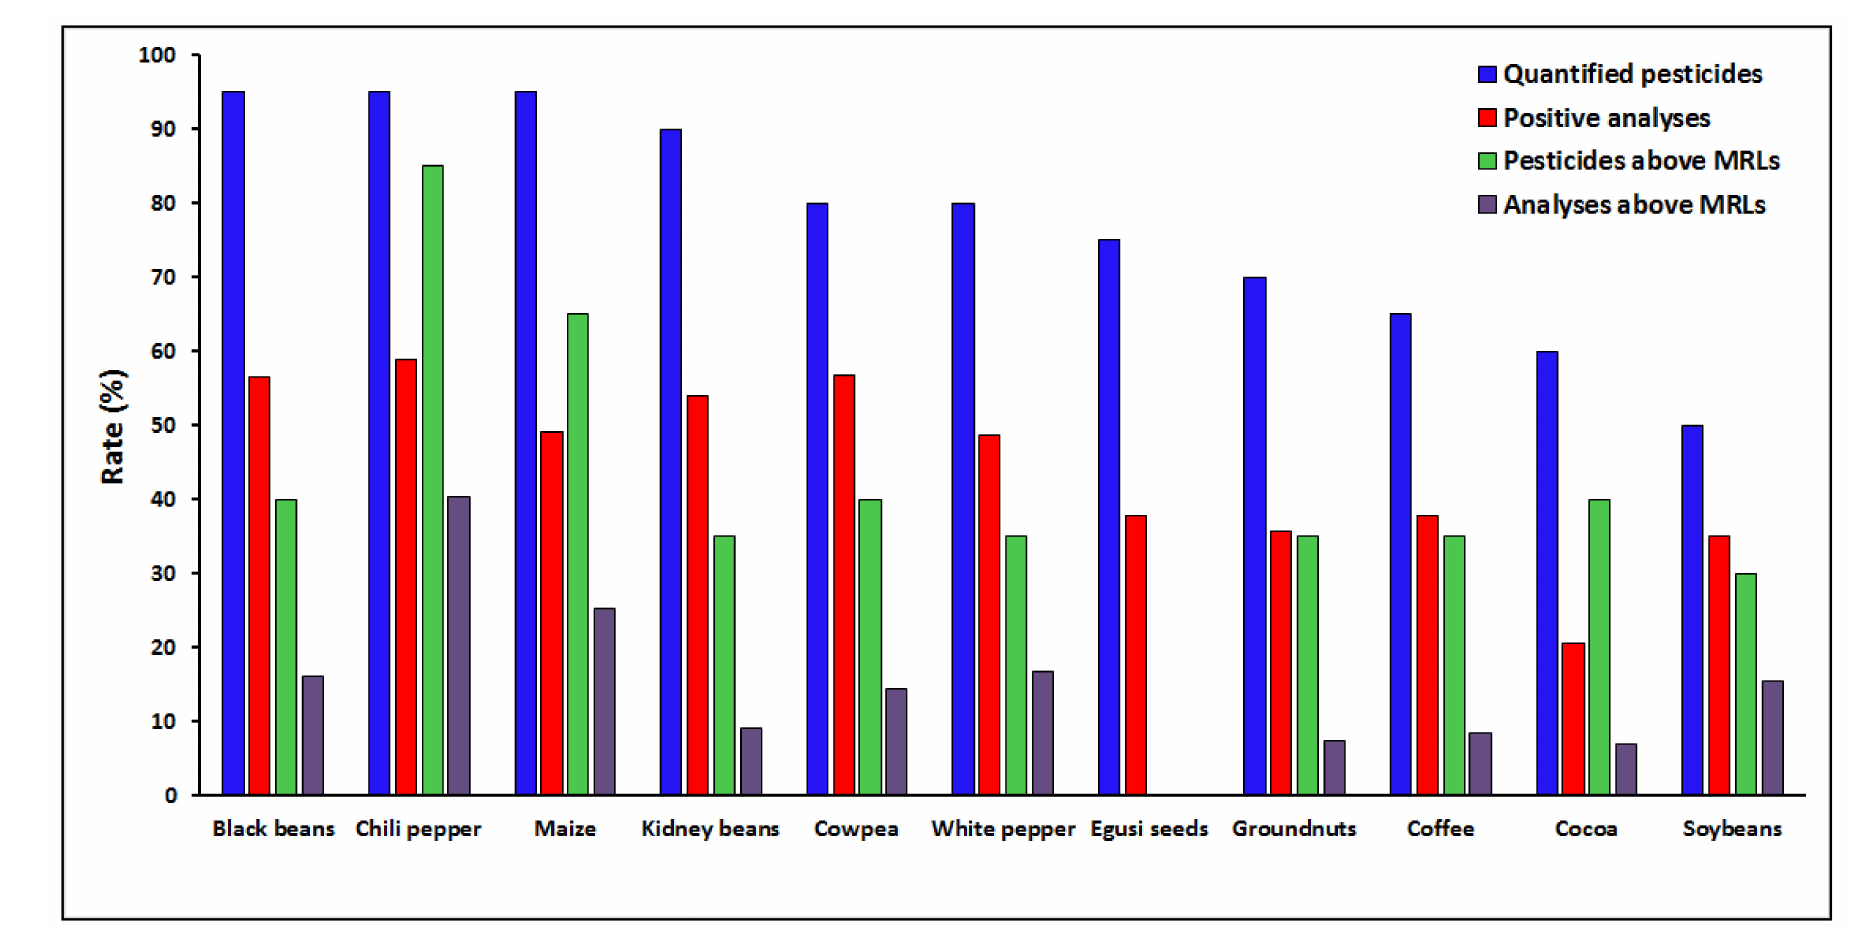
Figure 3. Representation of quantified halogenated pesticide residues among 11 food items from the 3 largest cities of